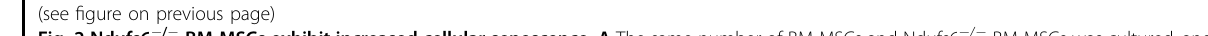
OCR and ATP production signi fi cantly reduced in Ndufs6 − / − -BM-MSCs (Fig. S9B, C). However, basal